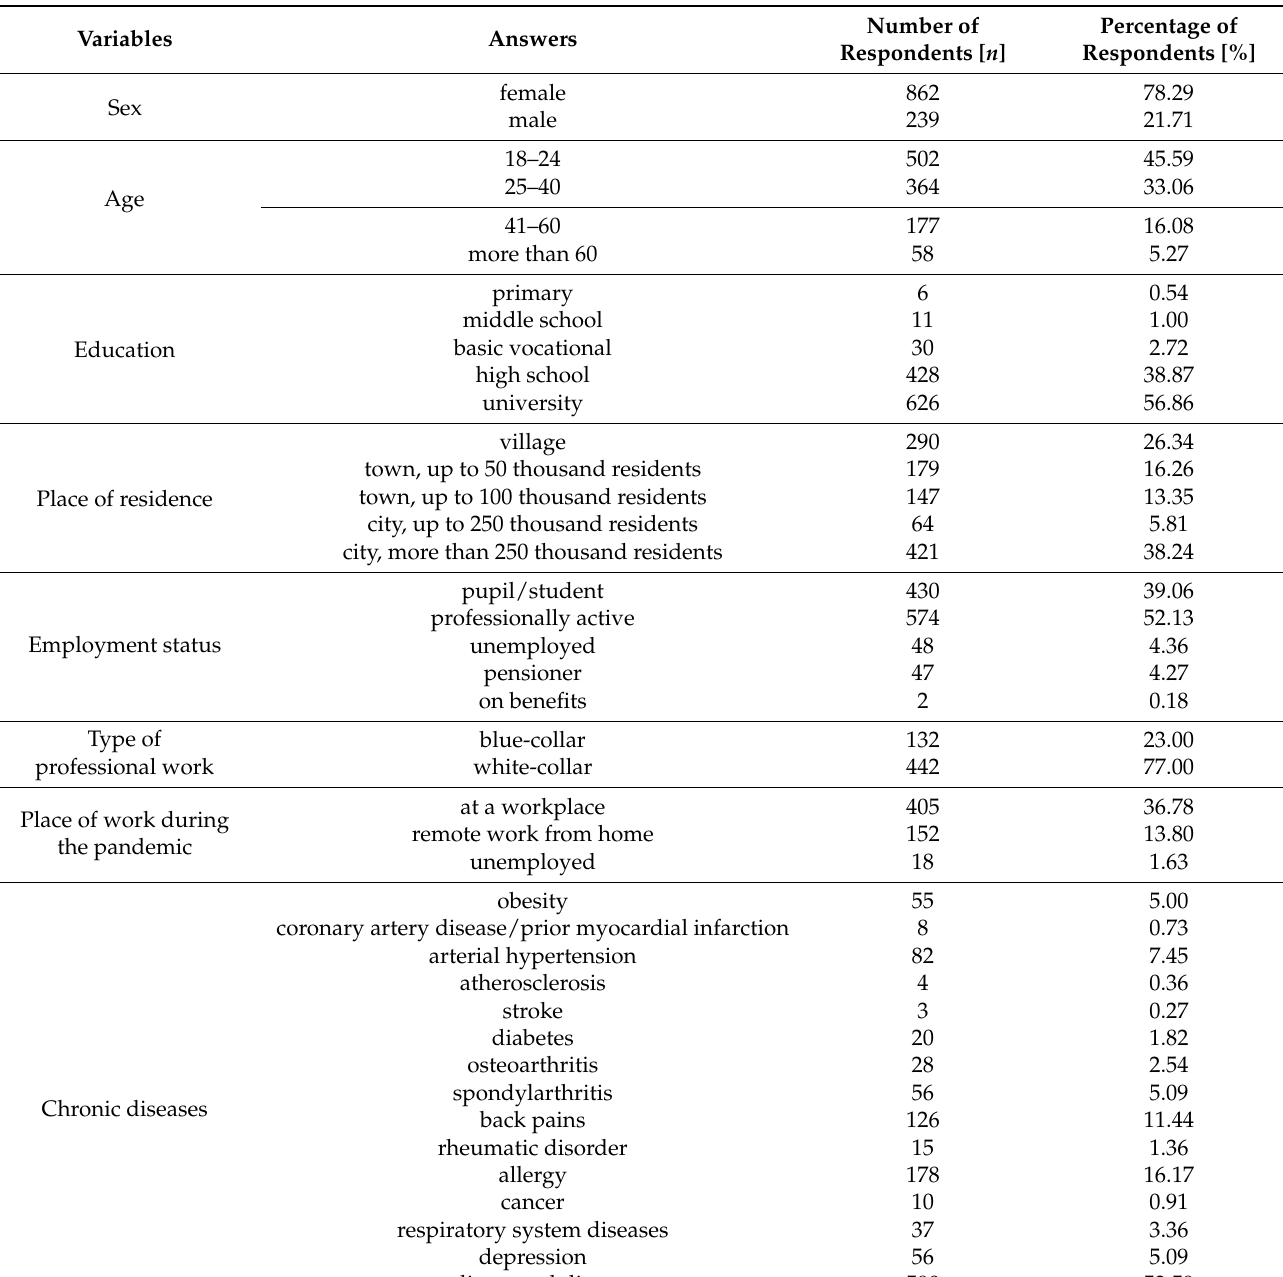
Table 1. Sociodemographic and clinical characteristics of the surveyed Poles ( n =